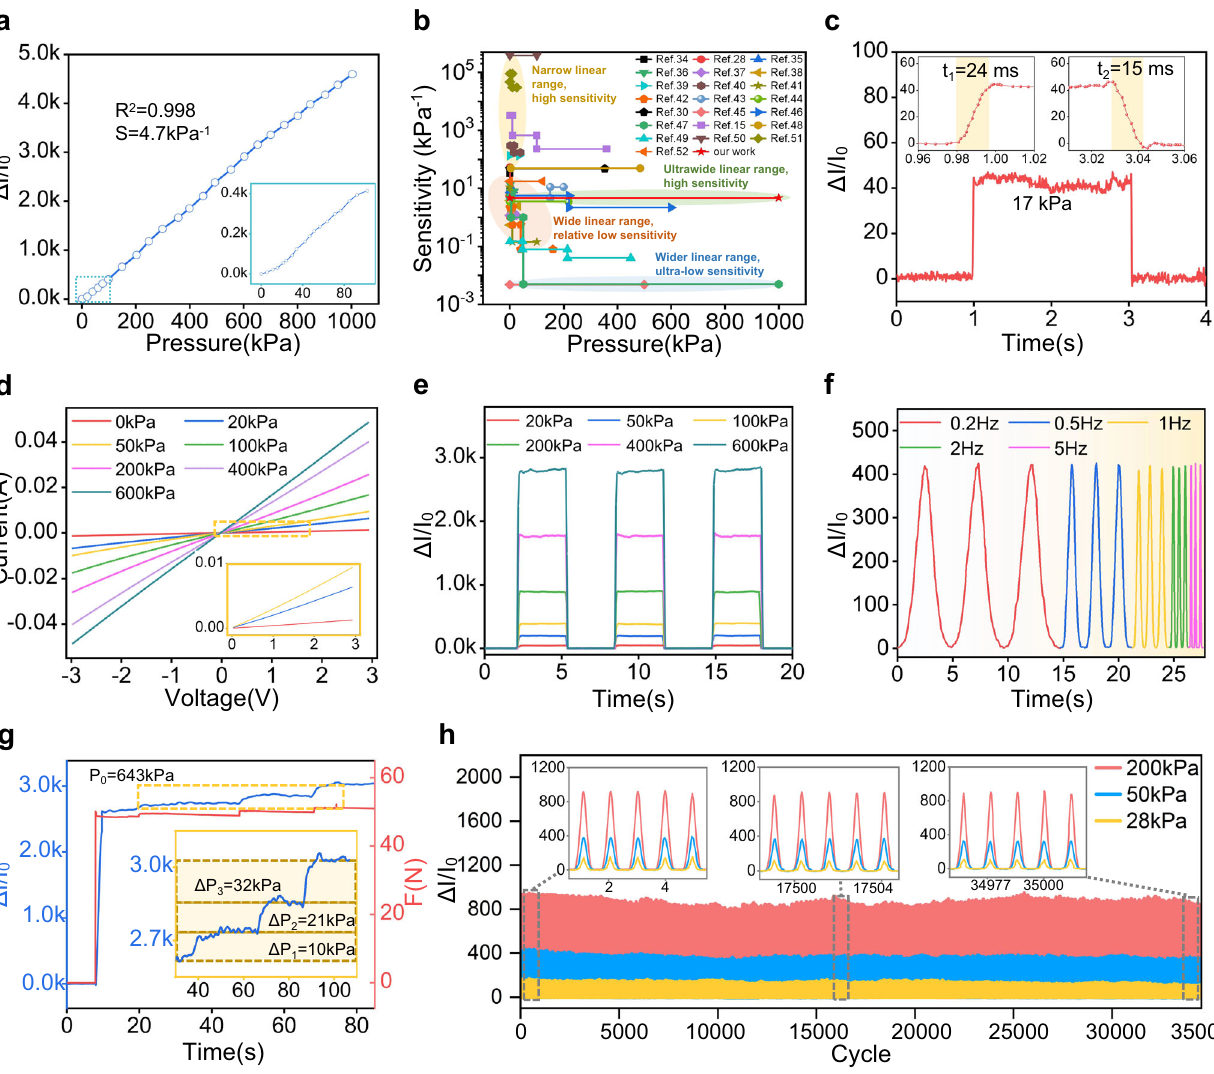
Fig. 3 Evaluation of electromechanical performance of HPPS. a Relative current change based on the optimized sensing layer under different pressures (0.032 kPa – 1000 kPa). b Comparison of the sensitivity of our pressure sensor with other reported literatures. c Response and recovery times of the HPPS under the pressure of 17 kPa. d Current-voltage curves of the HPPS under different pressures. e Dynamic response of the HPPS under loading/unloading cycles from low pressure to high pressure. f Dynamic response of the HPPS under 100 kPa at different frequencies. g Detection of tiny pressure under pre-compression of 643 kPa. h Repeatability performance of HPPS over 35,000 loading/unloading cycles under the pressure of 28 kPa, 50 kPa, and 200 kPa